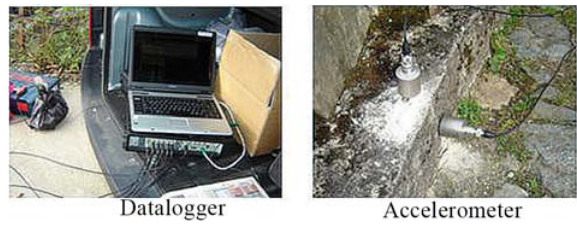
Fig. 7. The pictures from ambient vibration